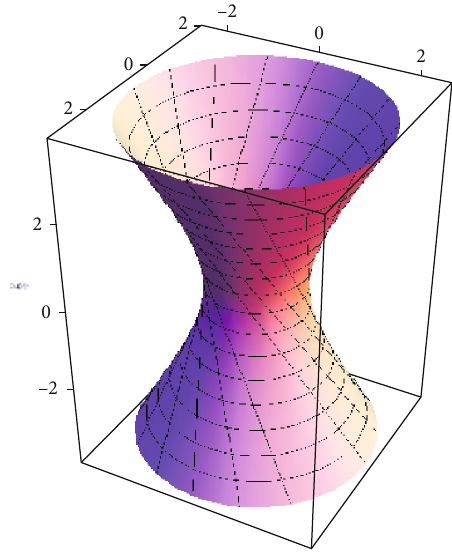
Figure 6: ð X Þ with h = 0 and ψ ∗ = 1 :